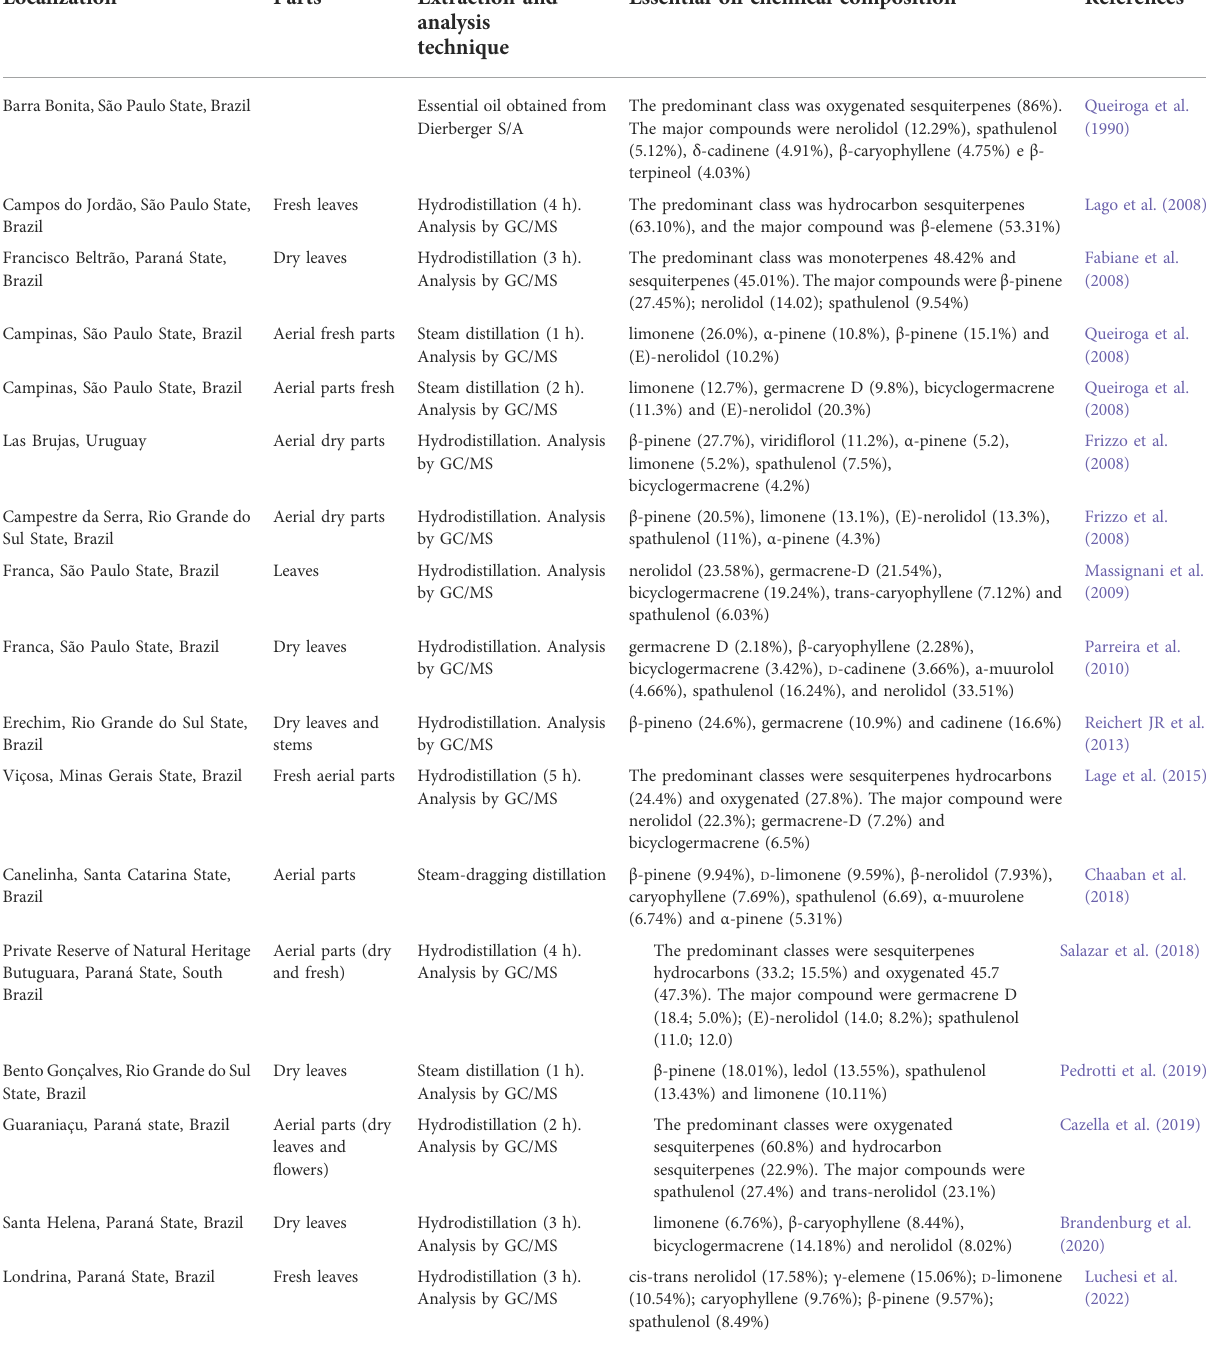
TABLE 2 Chemical Composition of Baccharis dracunculifolia essential